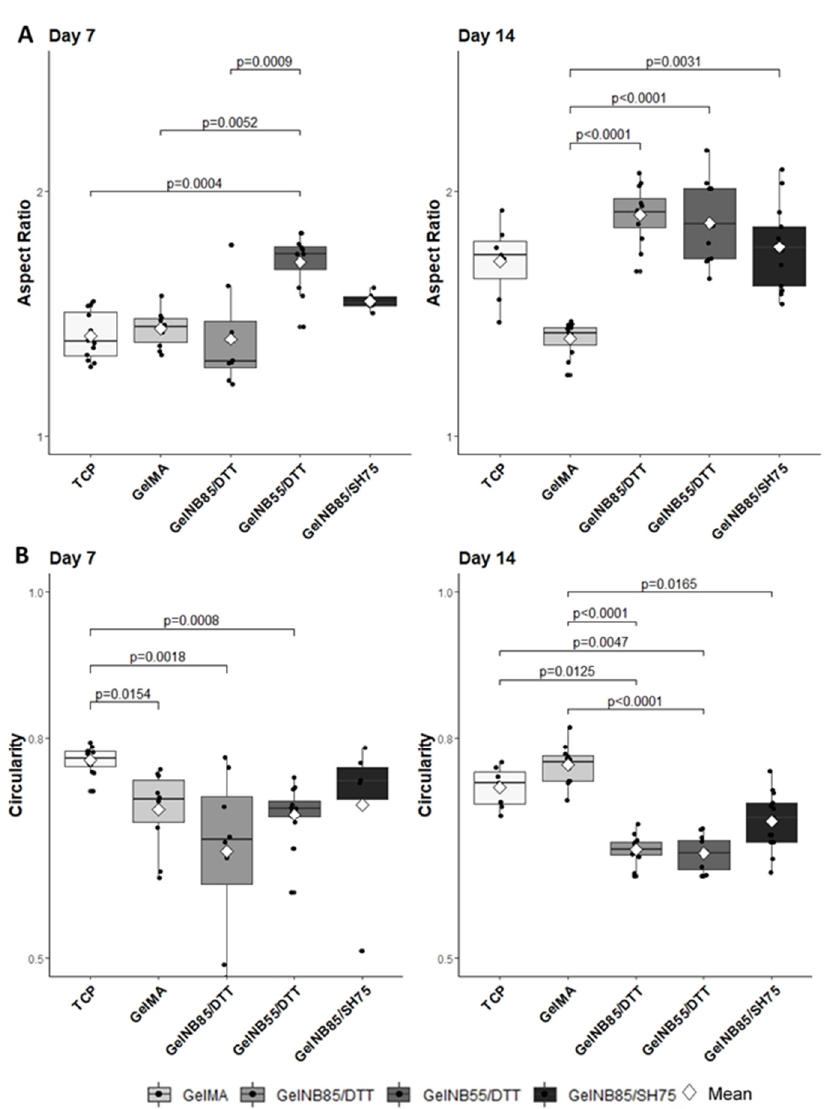
Figure 7. Tenocyte characteristics as determined on thiol-ene based hydrogels and compared to both TCP and gel-MA: ( A ) nuclear aspect ratio (AR): ratio of the major nuclear axis to the minor nuclear axis. An elongated cell shape is represented by a higher aspect ratio, and ( B ) circularity: a perfect circle has a value of 1. Significant differences are shown with adjusted p -values. Favorable tenocyte characteristics are high AR and low circularity, as expressed on all thiol-ene based hydrogels, most clearly pronounced on day 14. DTT: 1,4-dithiotreitol; gel-MA: methacrylated gelatin; gel-NB: norbornene-functionalized gelatin; gel-SH: thiolated gelatin; TCP: tissue culture